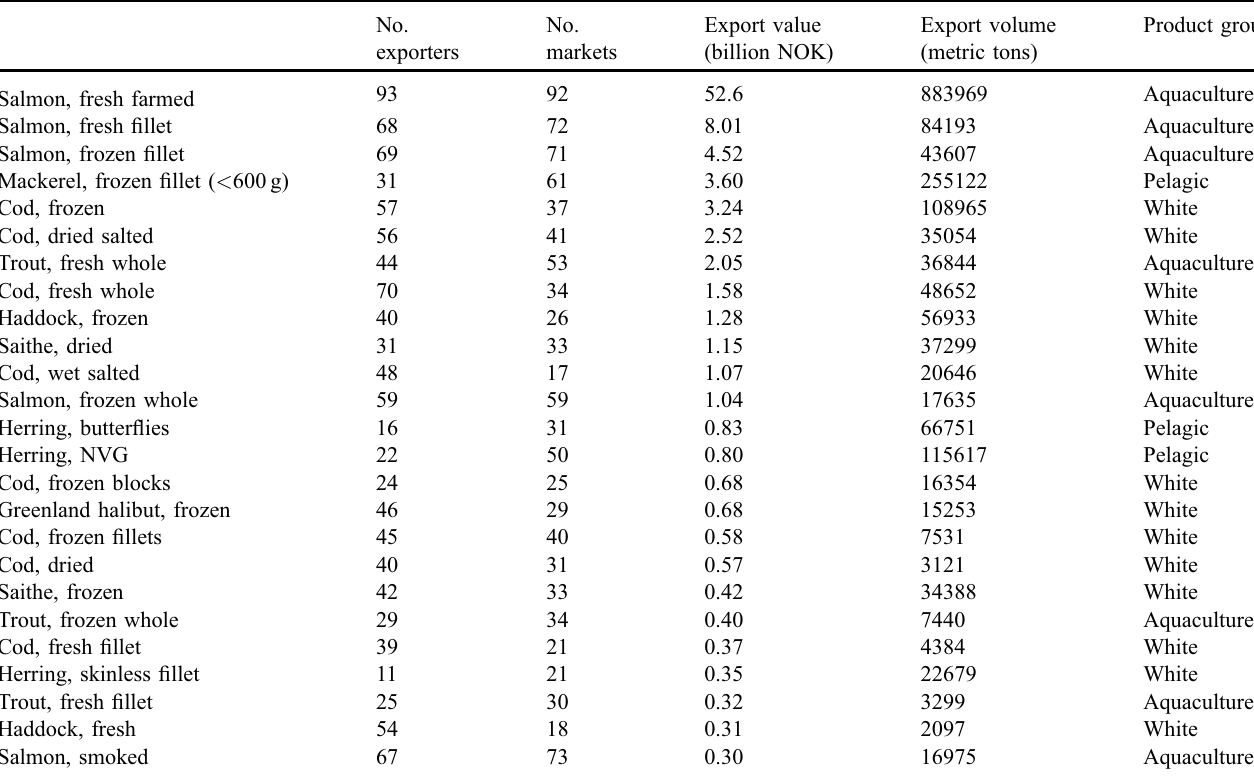
Table 1. Descriptive statistics. 25 largest export products. Annual averages for 2016 – 2020.